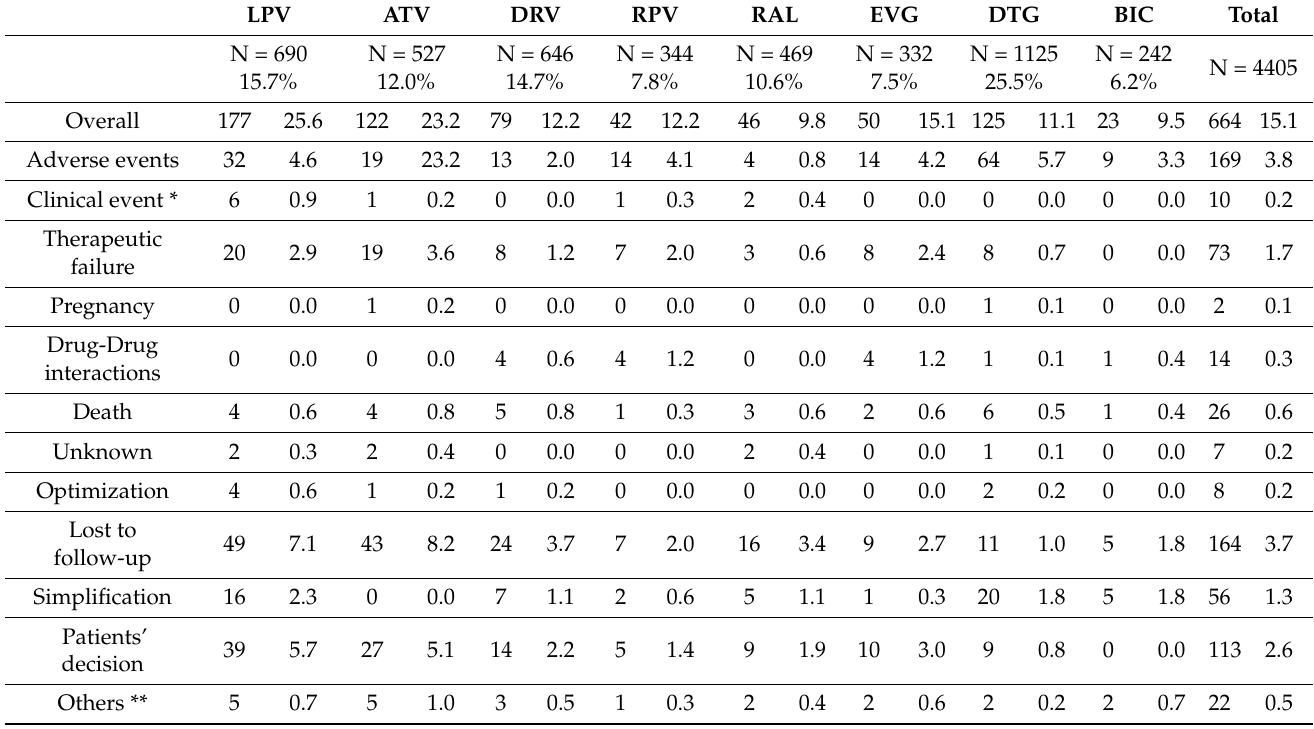
Table 2. Reason of interruption during the first year of treatment in 4405 people living with HIV, by SCOLTA cohort.